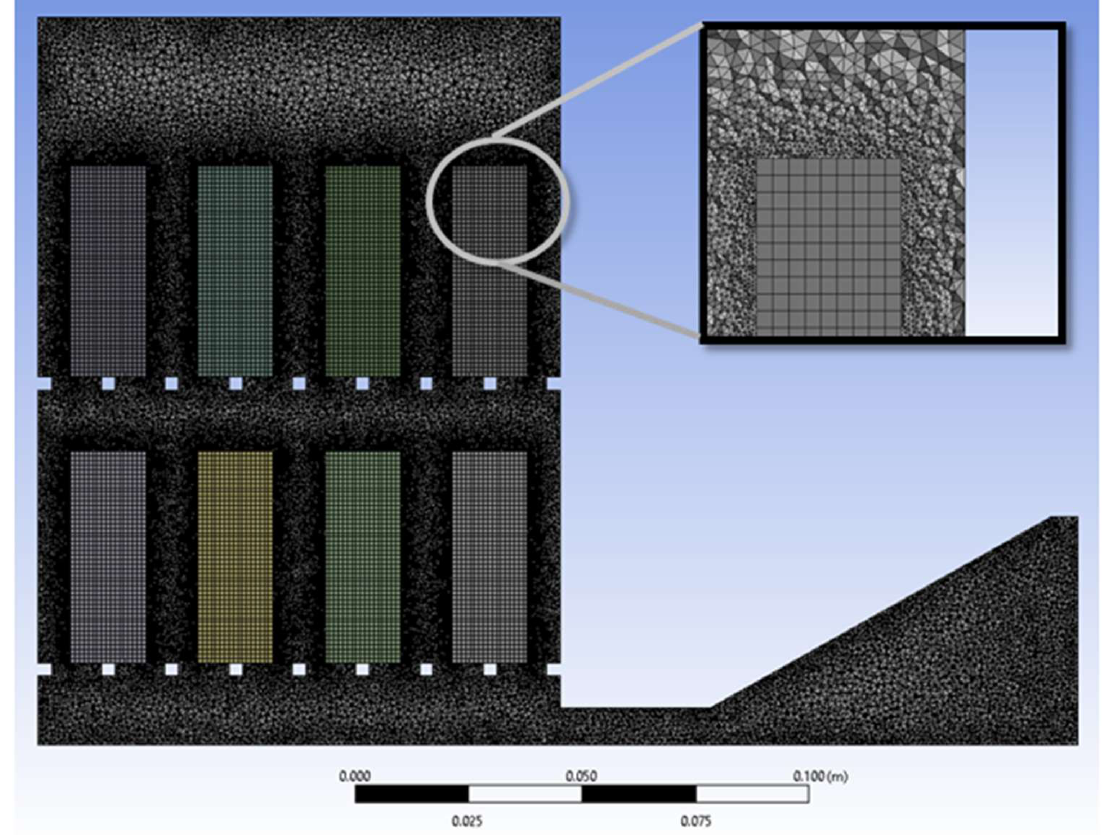
Figure 9. Mesh domain used in simulation of the experimental model. A section plane operation has been applied to show in the internal fluid domain and the batteries contained within. In addition, an enlarged 3D rendering of the mesh surrounding the corner of a single battery can be seen in the top right corner of the figure.